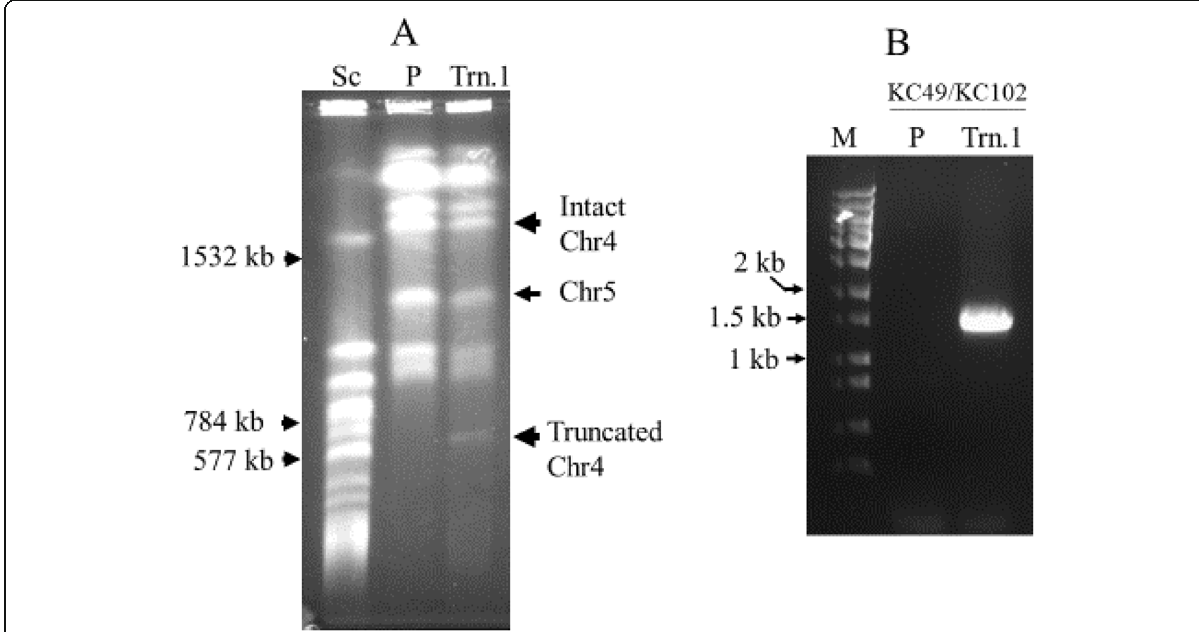
Fig. 2 Verification of truncation 1. A Karyotypic verification of truncation 1 (969.925 kb position) of chromosome 4 using contour-clamped homogenous electric field (CHEF). Sc, Saccharomyces cerevisiae chromosomes used as size marker, three relevant chromosome sizes are indicated by arrows at 1532 kb, 784 kb and 577 kb respectively; P, wild type strain CAF4-2; Trn.1, chromosomes of the strain carrying truncation 1. Arrows indicated for the intact homolog and truncated version of Chr4. Truncation at 969.925 kb position (~ 970 kb) generates a 633 kb long truncated version of Chr4. It runs between 784 kb and 577 kb marker chromosomes of S. cerevisiae . B PCR verification of truncation 1 with specific